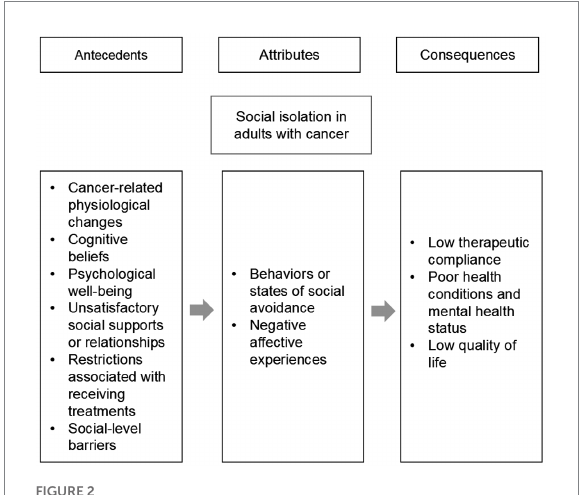
FIGURE 2 Model of social isolation concept in adults with